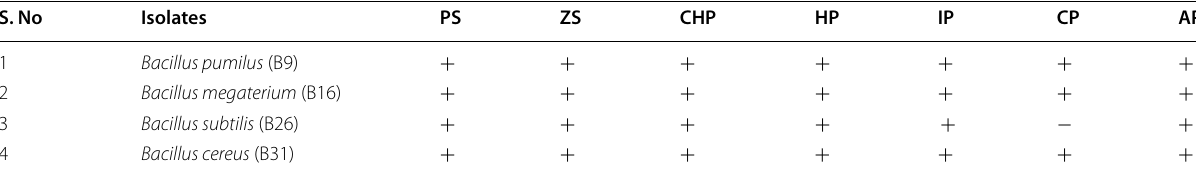
PS, phosphate solubilization; ZS, zinc solubilization; CHP, chitinase production; HP, HCN production; IP, IAA production; CP, catalase production; AP, ammonia production (NH